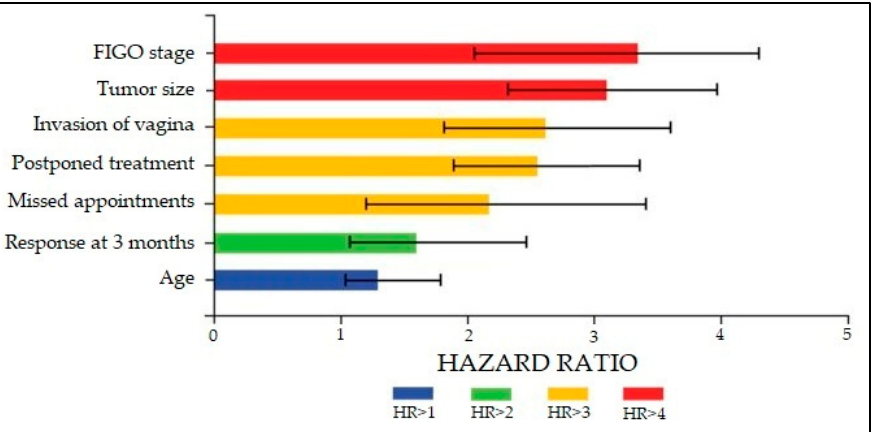
FIGO—International Federation of Gynecology and Obstetrics; HR—Hazard Ratio; CI—Confidence Interval.